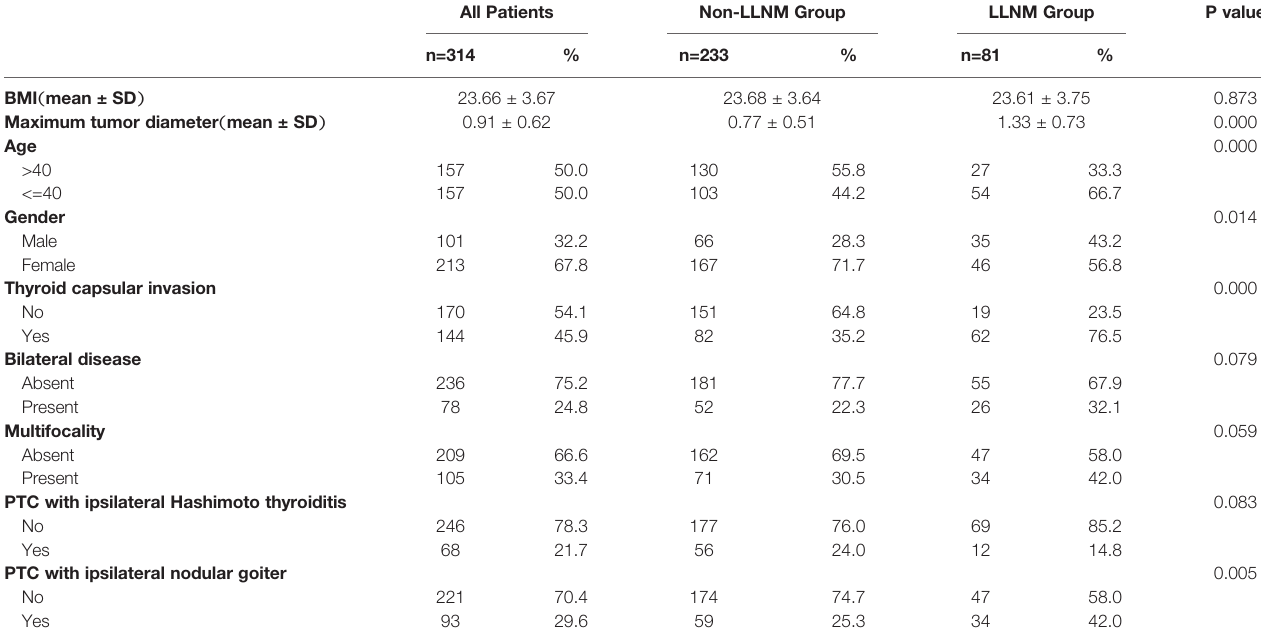
TABLE 3 | The clinicopathological characteristics of patients with tumor located in upper portion.